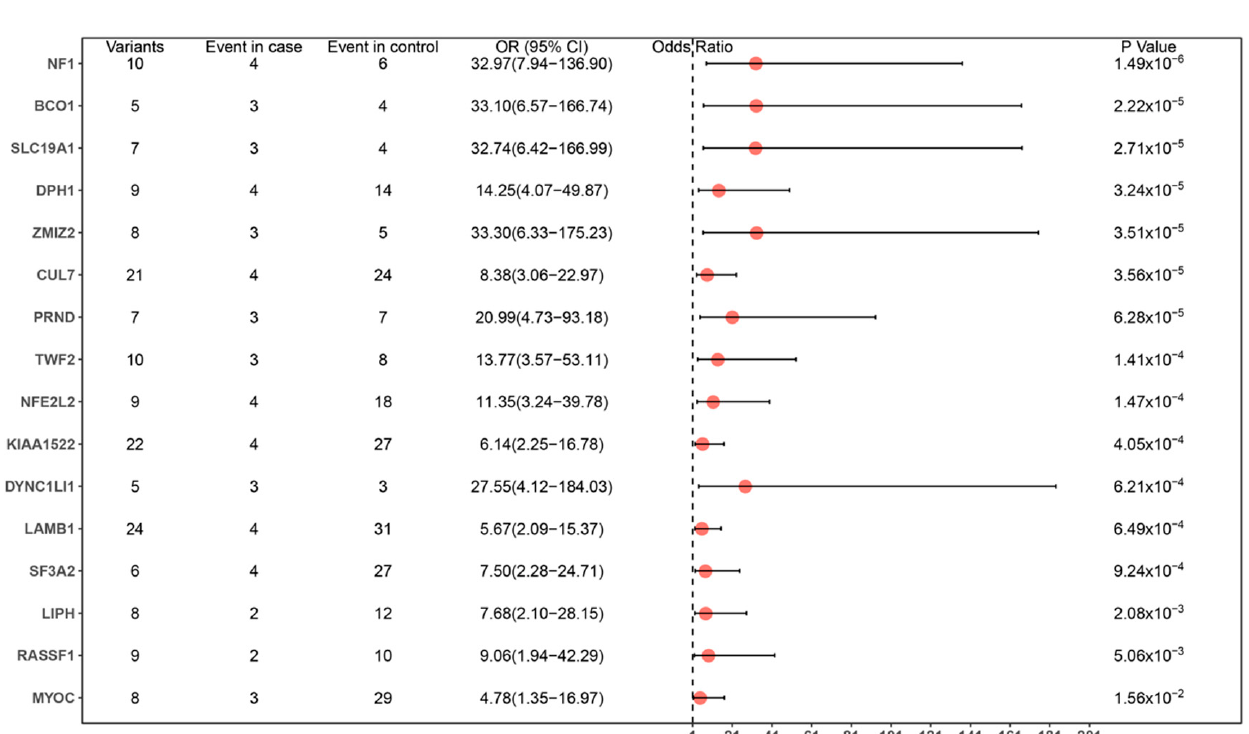
Figure 3. The top 15 enriched GO terms for the identified 37 genes using the clusterProfiler pack- age.